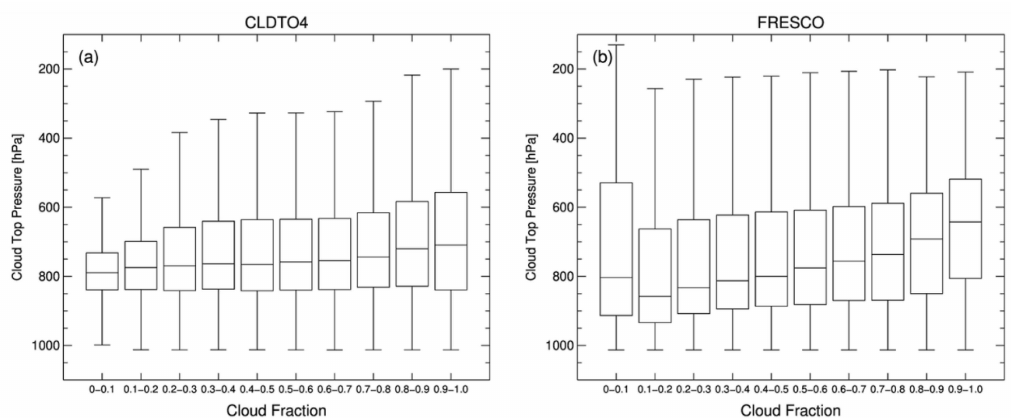
Figure 5. Boxplot of distribution of CTP as function of CF for each cloud retrieval algorithm: ( a ) CLDTO4 and ( b )